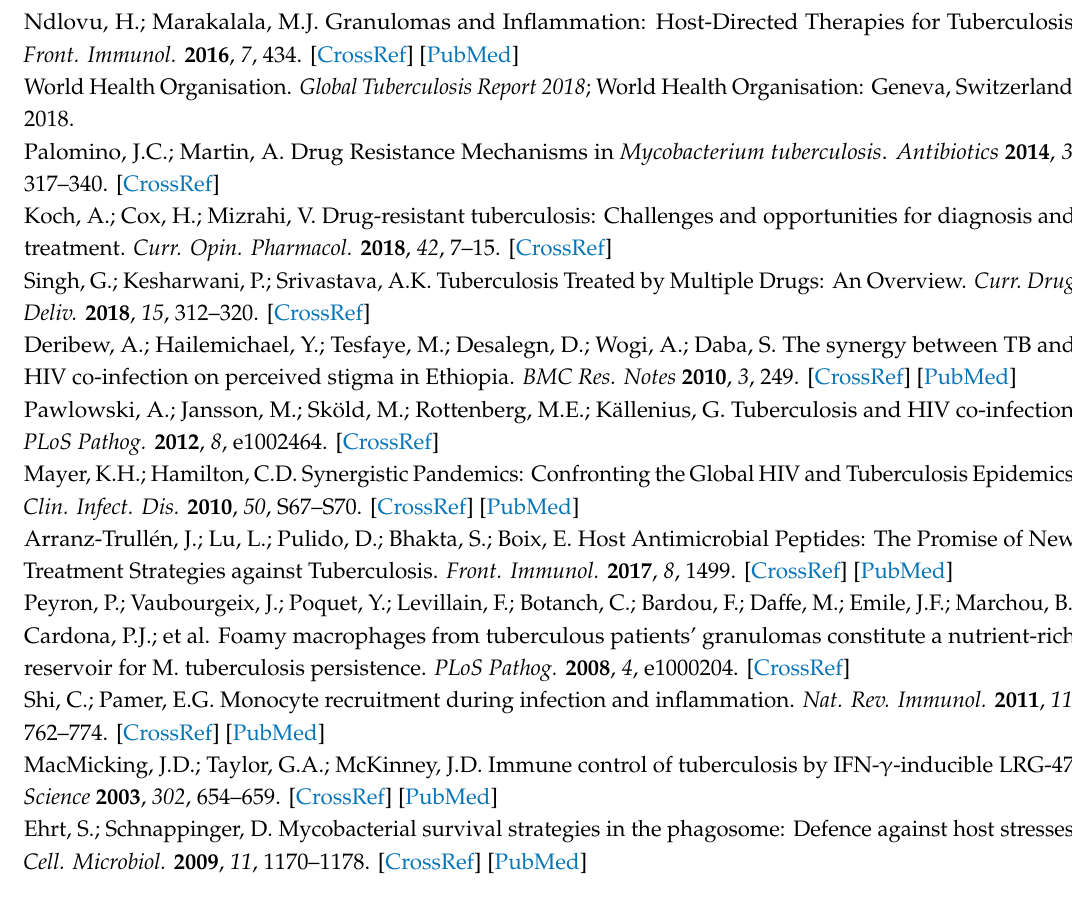
Figure S1. 1 H NMR spectrum of raw inulin microparticles; Figure S2. 1 H NMR spectrum of oxidized inulin; Figure S3. 1 H NMR spectrum of inulin conjugate; Figure S4. 1 H NMR spectrum of pure INH; Figure S5. FTIR Spectrum of pure INH; Figure S6. FTIR Spectra of inulin and inulin-INH conjugate between 1800 and 800 cm − 1 ; Table S1. shows The relationship between oxidation time and INH loading; Table S2. Preparation of SBF; Table S3. Preparation of